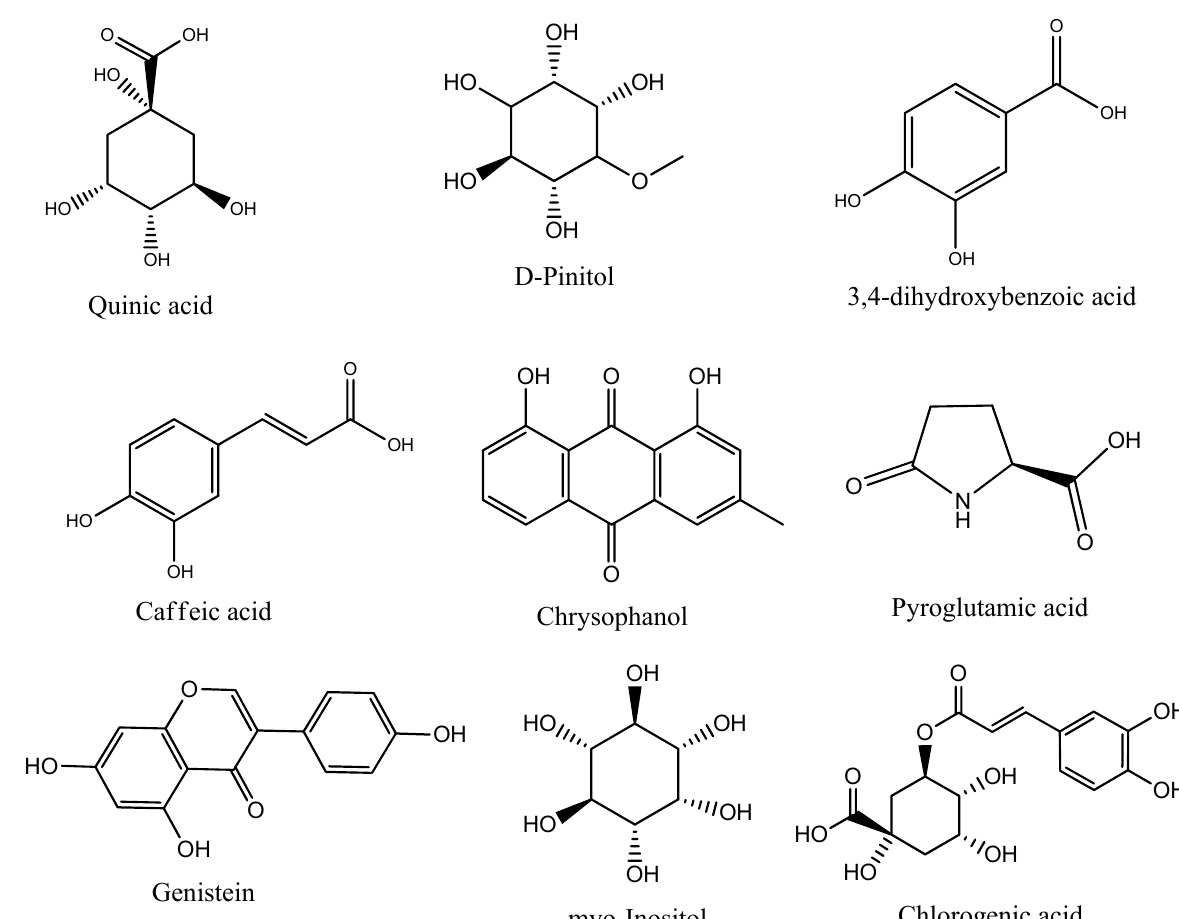
Figure 1. Chemical structure of the anti-diabetic and GLUT4 translocation enhancer phytochemicals exciting in the 10 GT fractions.